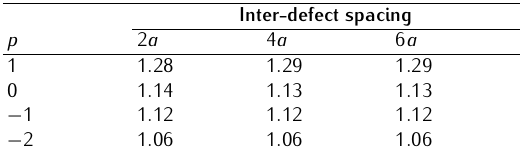
Table 5. The formation energy of dopant-vacancy configuration, E dop−v